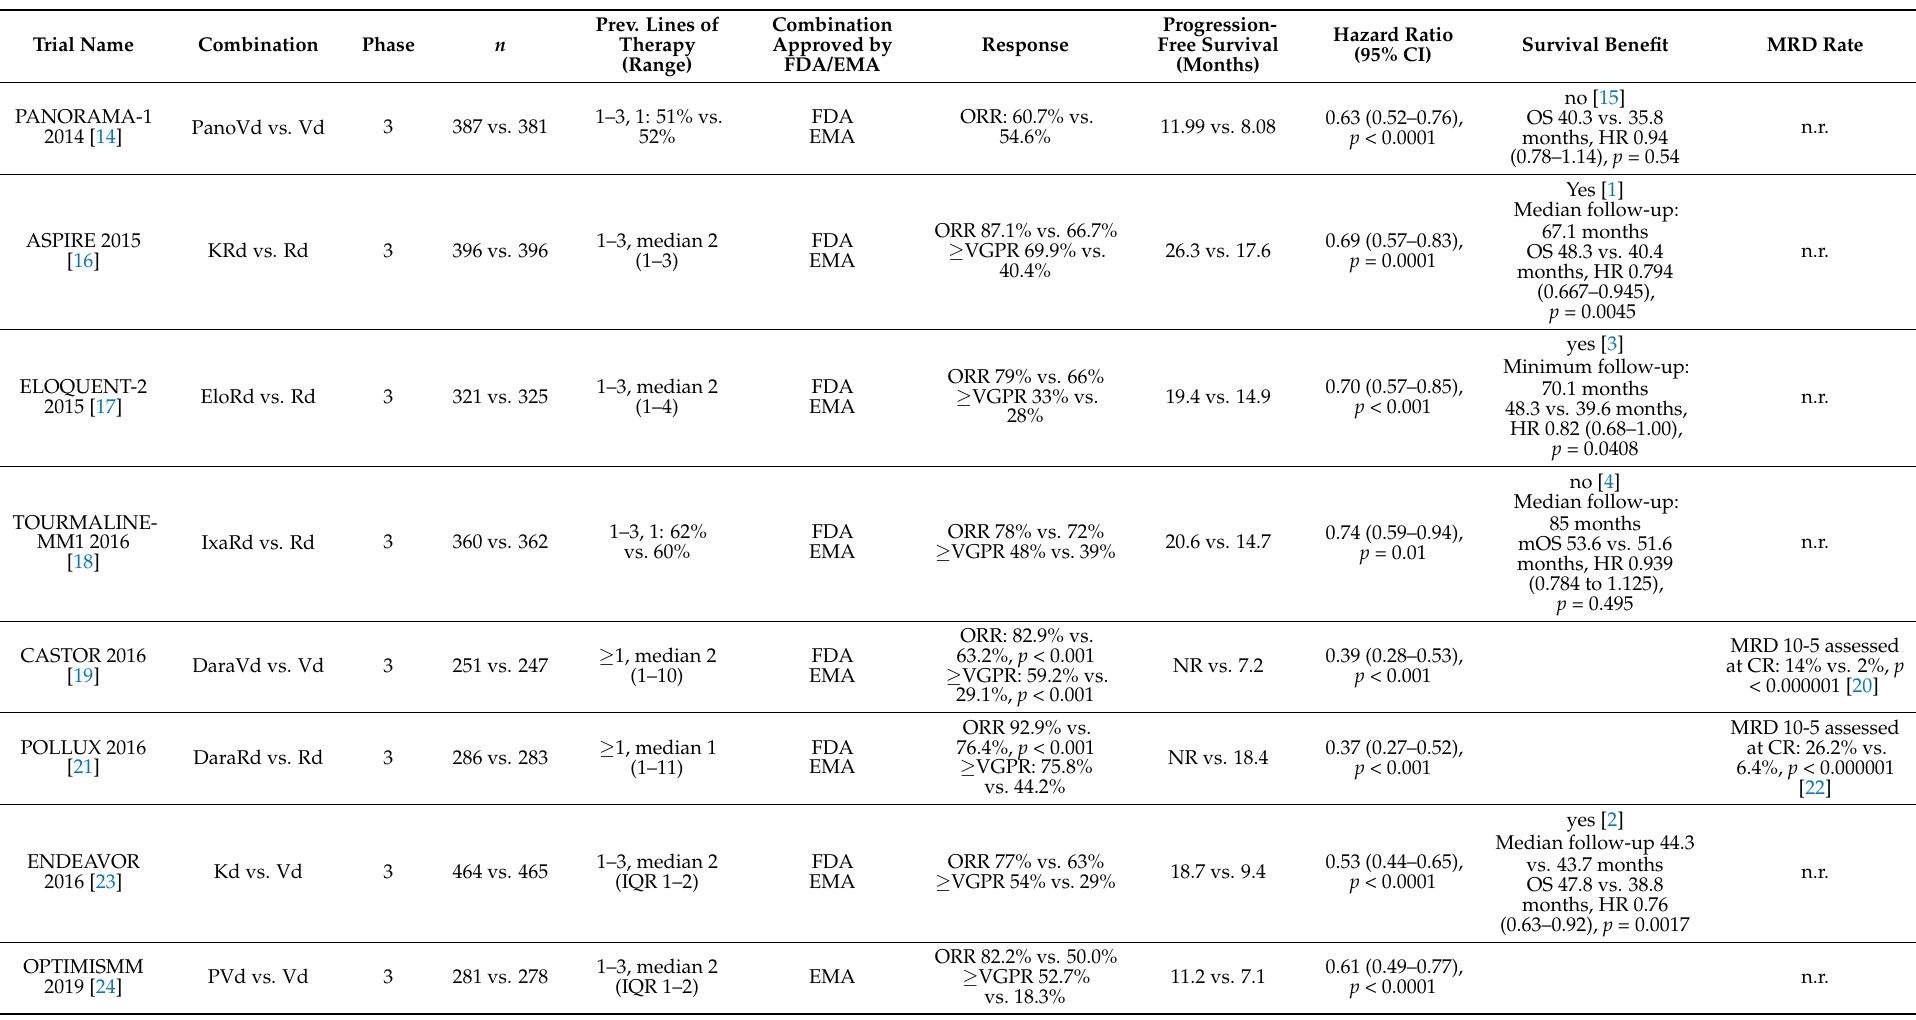
Table 1. Landmark trials in multiple